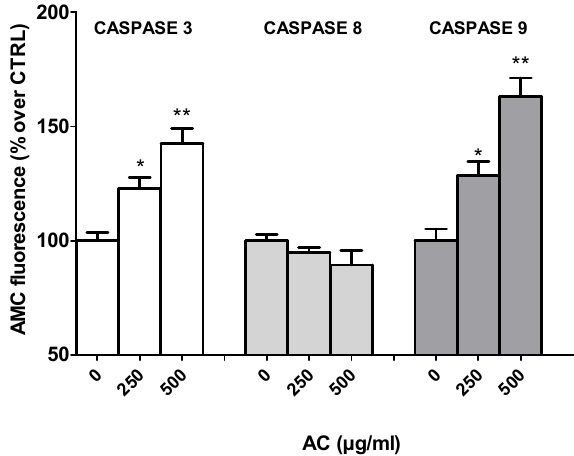
Figure 5. Acacia catechu Willd. extract (AC)-mediated effects on caspase-3, 8 and 9 activities in human colorectal adenocarcinoma HT-29 cells. The specific fluorogenic substrates DEVD-AMC (caspase-3), IETD-AMC (caspase-8) and LEHD-AMC (caspase-9) were used, and so was the fluorescence of the AMC-fragment released by active caspases measured at 380 and 460 nm excitation and emission wavelengths, respectively. Data are reported as means ± SEMs of at least three independent experiments in which four points / concentrations were run, and controls (AC 0 µ g / mL) represent untreated cells. * p < 0.05, ** p < 0.01 vs. controls (ANOVA followed by Dunnett post-test).